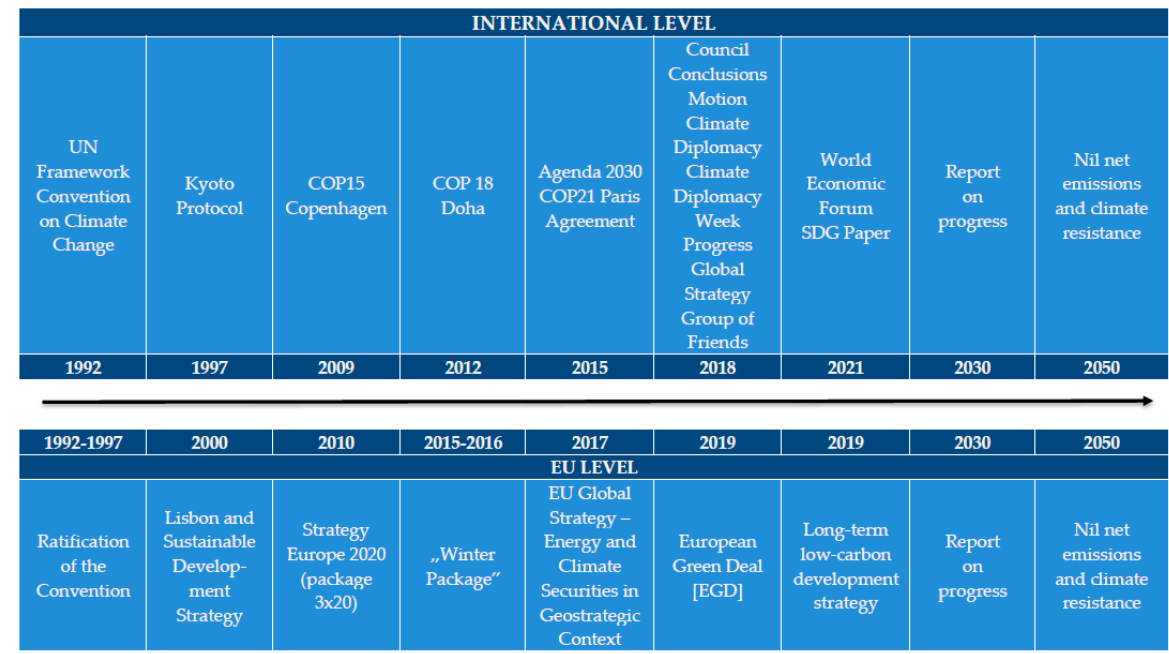
Figure 1. Timeline of EU initiatives /documents in the field of climate change and energy. Source: own study based on EU documents.